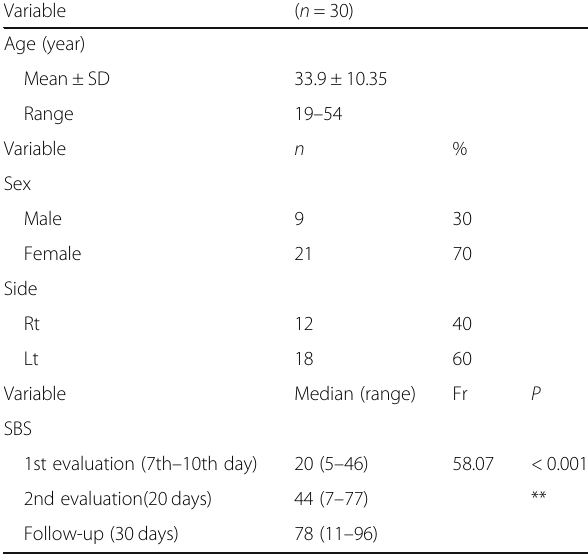
Table 1 Demographic and clinical data of studied